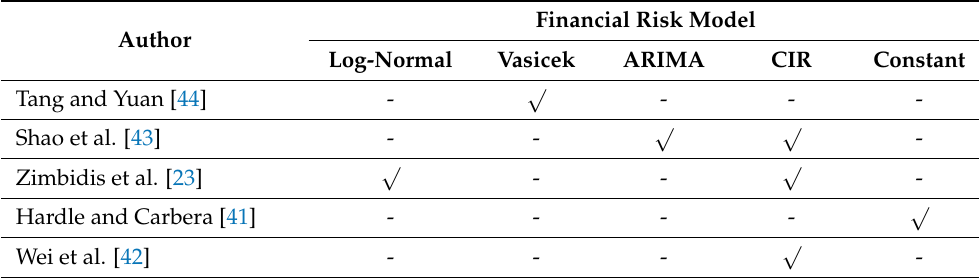
Table 8. Summary of financial risk model used in primary study.